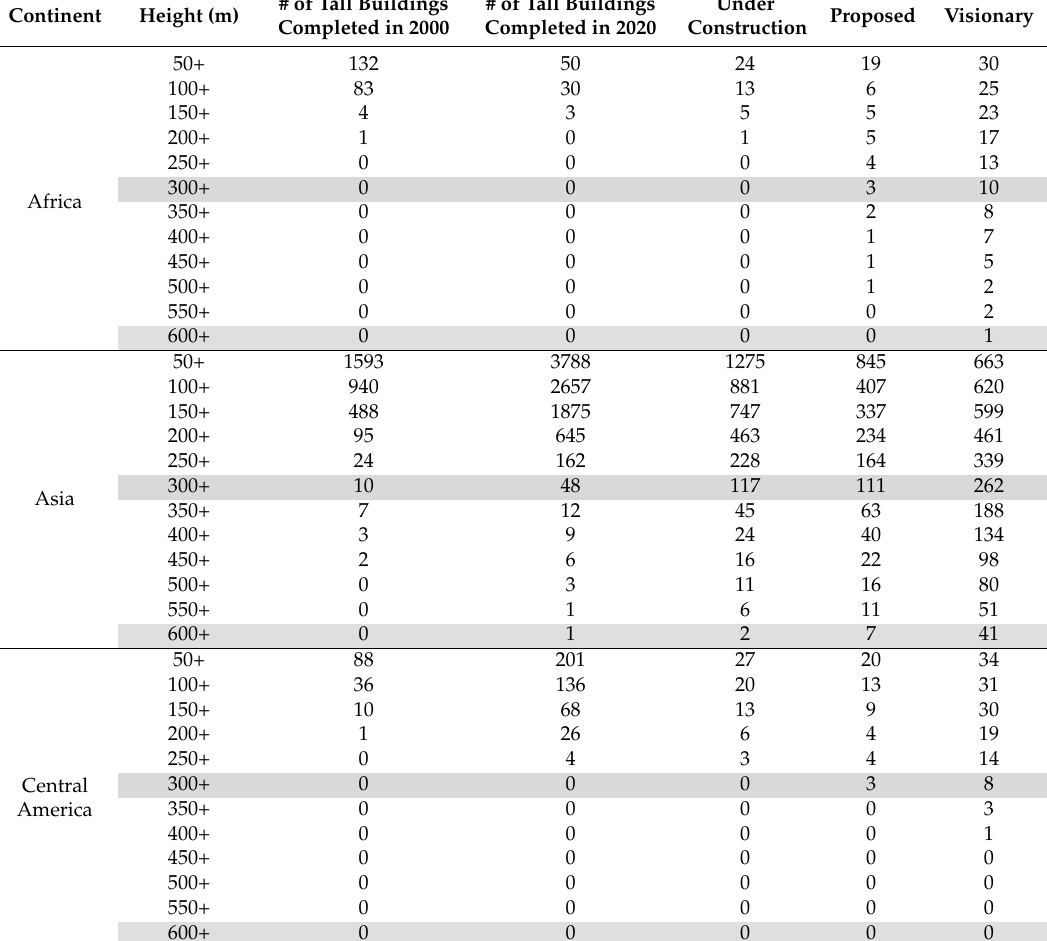
Table 4. Tall buildings in 2000 and 2020. The breakdown is based on world continents and buildings’ heights. Continent Height